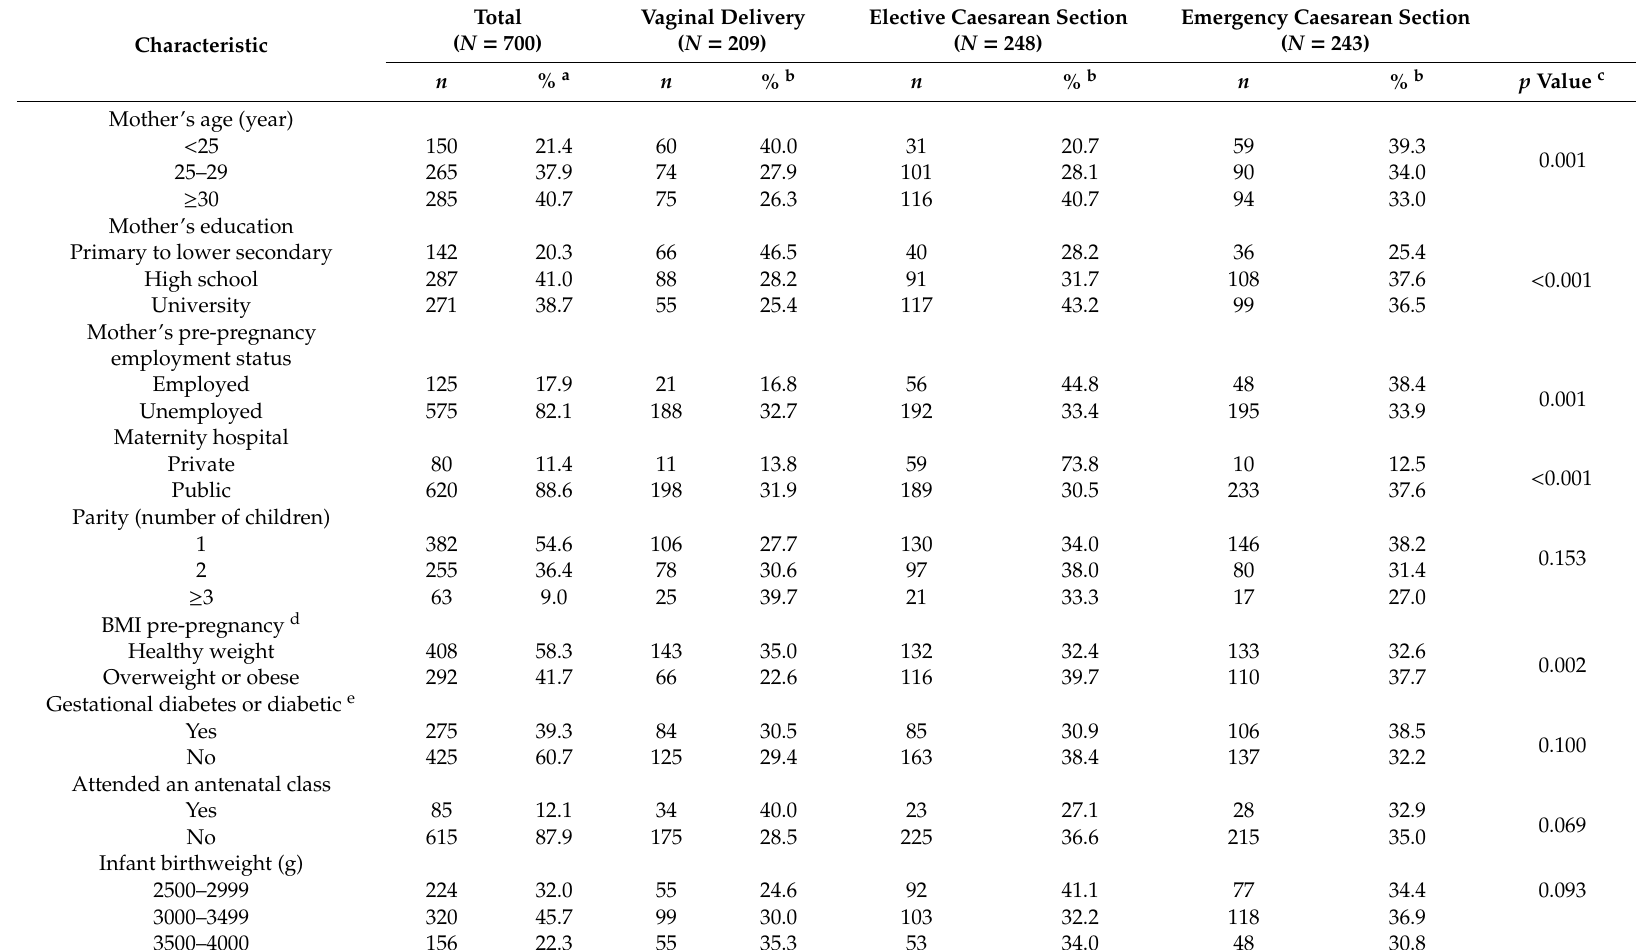
Table 2. Characteristics of participants and association with mode of